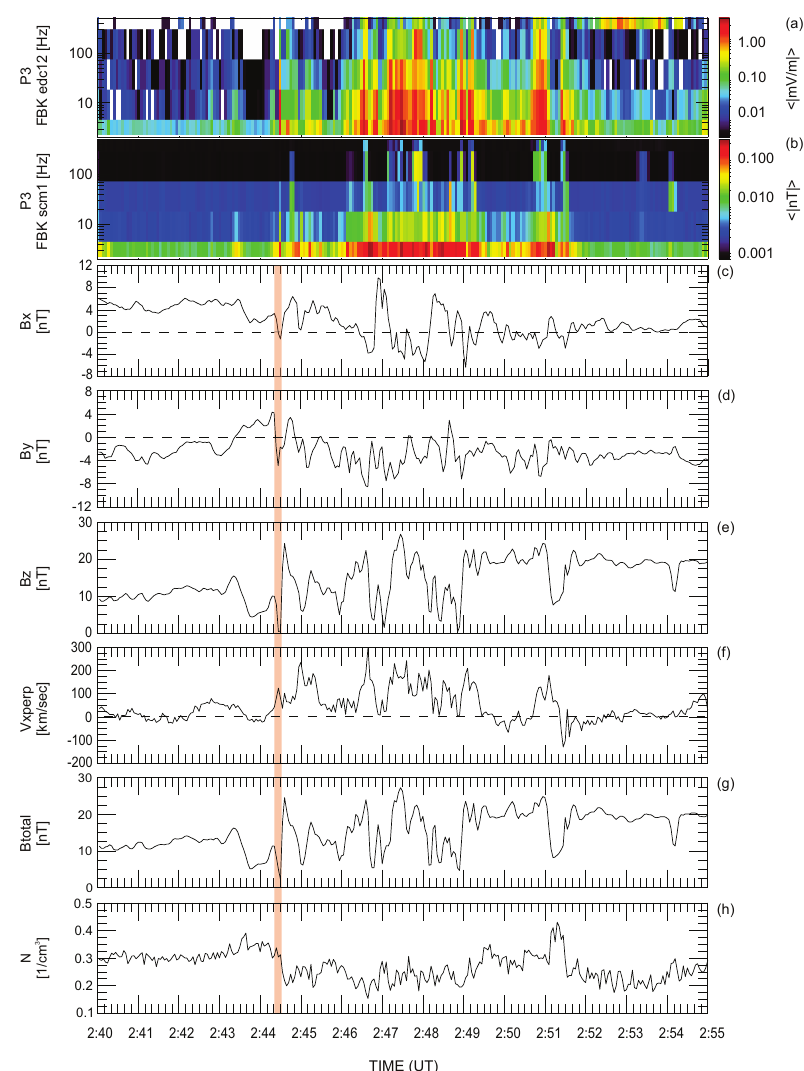
Fig. 5. Same format as Fig. 2 but for a 14 February 2008 substorm event. The measurements are from P3 spacecraft for the time interval 02:40–02:55UT and the spectral bands cover the frequency range from ∼ 2Hz to ∼